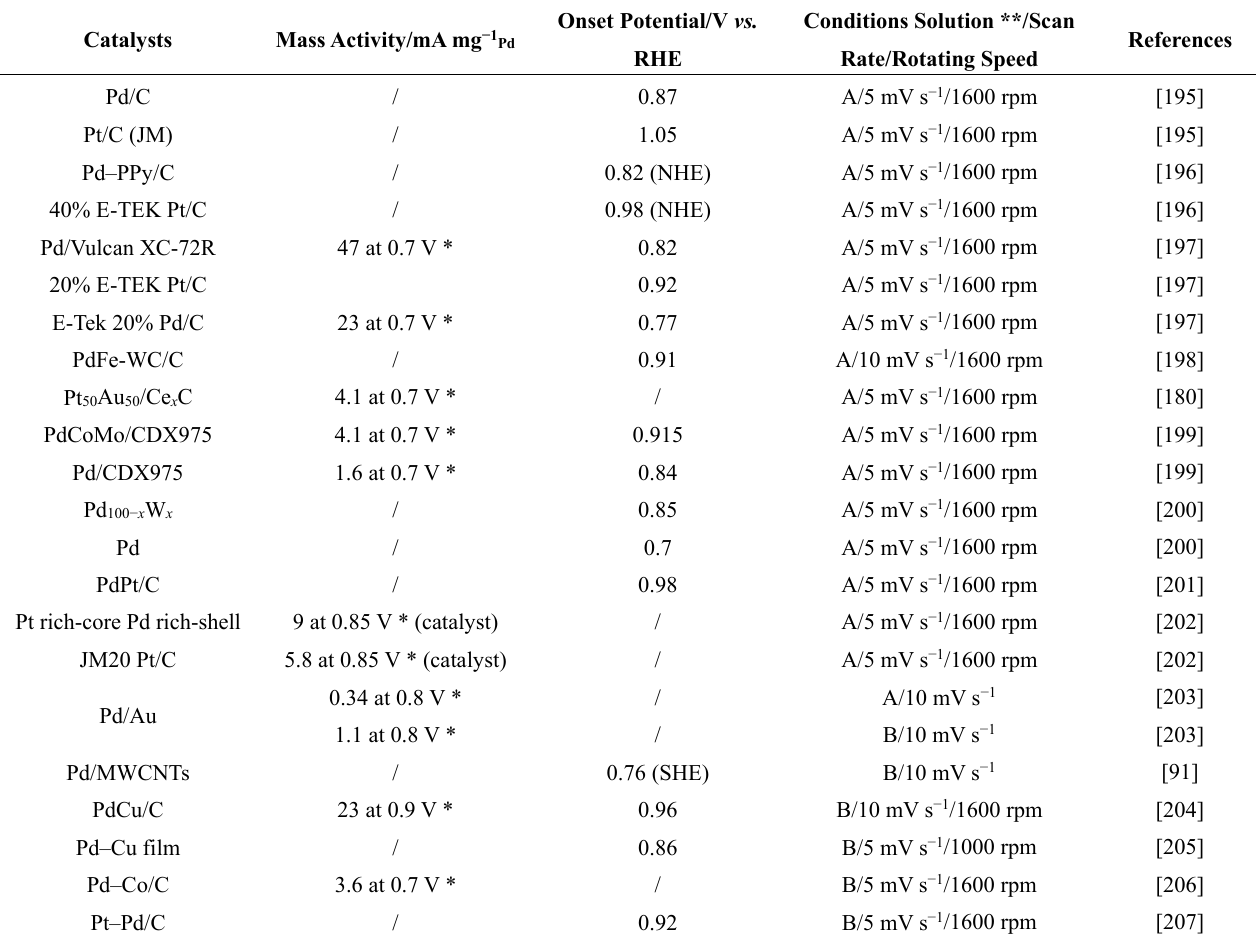
Table 3. Comparison of the onset potential and mass activity of Pd for oxygen reduction reaction